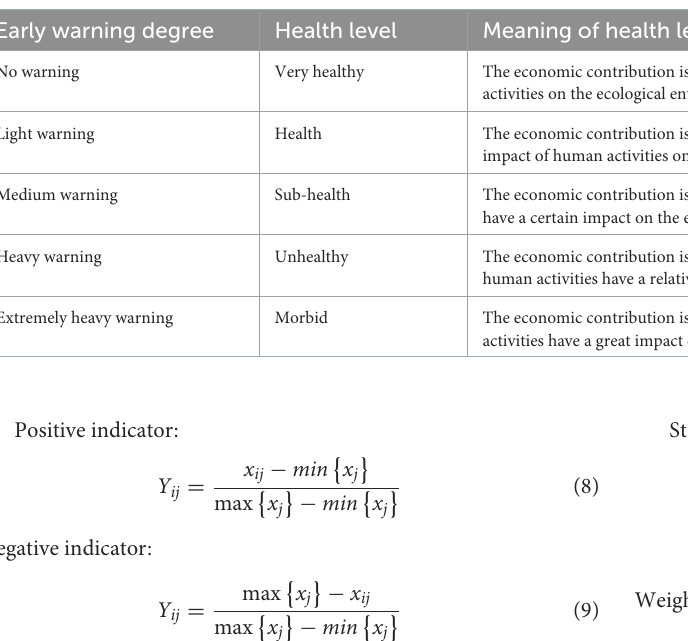
TABLE 4 Meaning of coastal ecosystem health